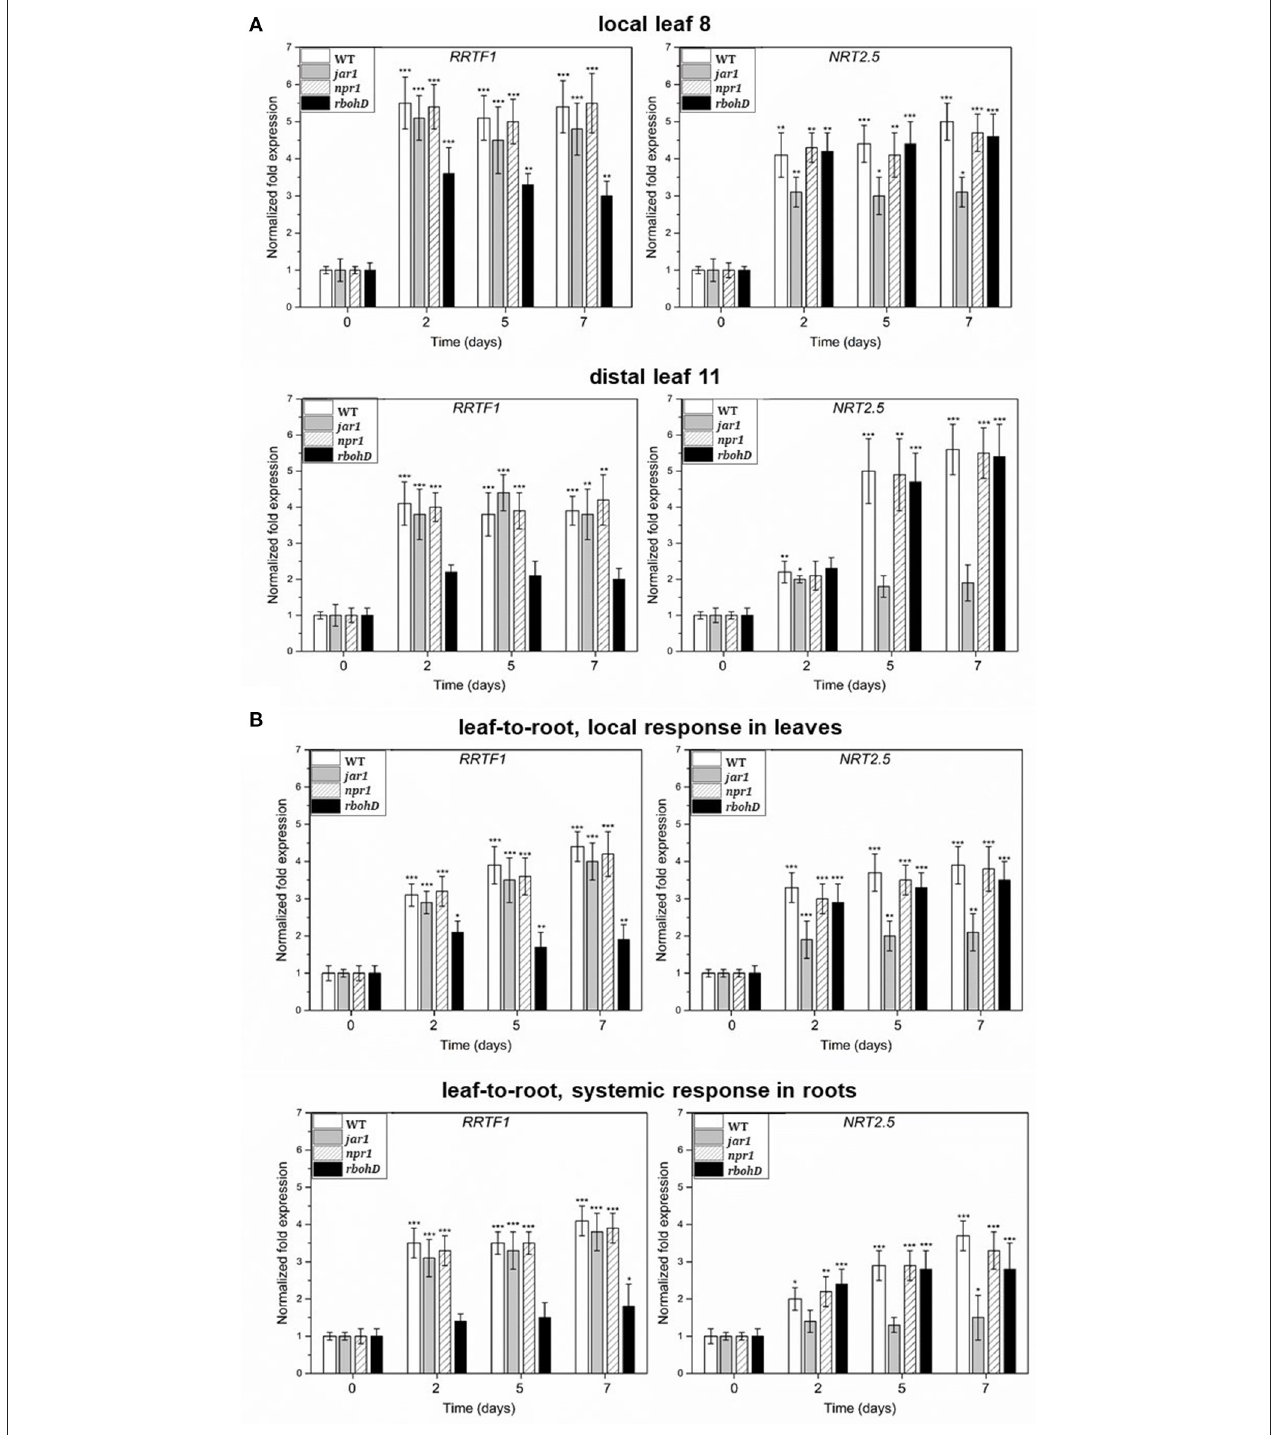
FIGURE 2 | (A) Induction of RRTF1 and NRT2.5 mRNA levels in the A. brassicae- infected leaf no. 8 and the systemic leaf no. 11 of WT, jar1, npr1, and rbohD plants. The treatment was the same as described in the legend to Figure 1A . (B) Induction of RRTF1 and NRT2.5 mRNA levels in the A. brassicae- infected leaves and the non-infected roots of WT, jar1, npr1 , and rbohD seedlings on agar plates, as shown in the Figure 1B . The treatment was the same as described in the legend to Figures 1A,B . The mRNA levels at day 0 were set as 1.0 and all other values were expressed relative to them ( ± SEs). Asterisks indicate significant differences of the values compared to the mock-treated controls (which are not shown, but comparable to the results shown for WT material in Figure 1 ), as determined by Student’s t -test (* P ≤ 0.1; ** P ≤ 0.01; *** P ≤ 0.001).